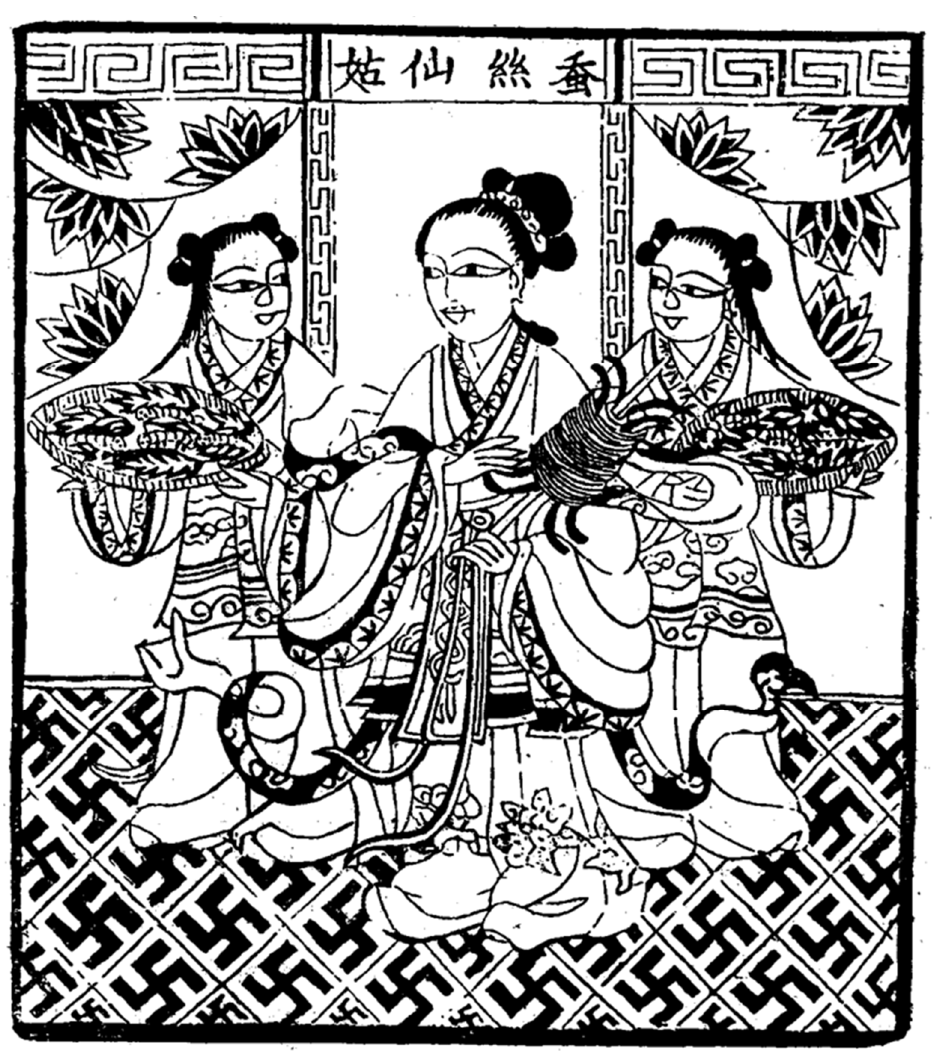
Figure 10. “Can Si Xian Gu 蚕丝仙姑 ” (Gu 1991, p. 78).